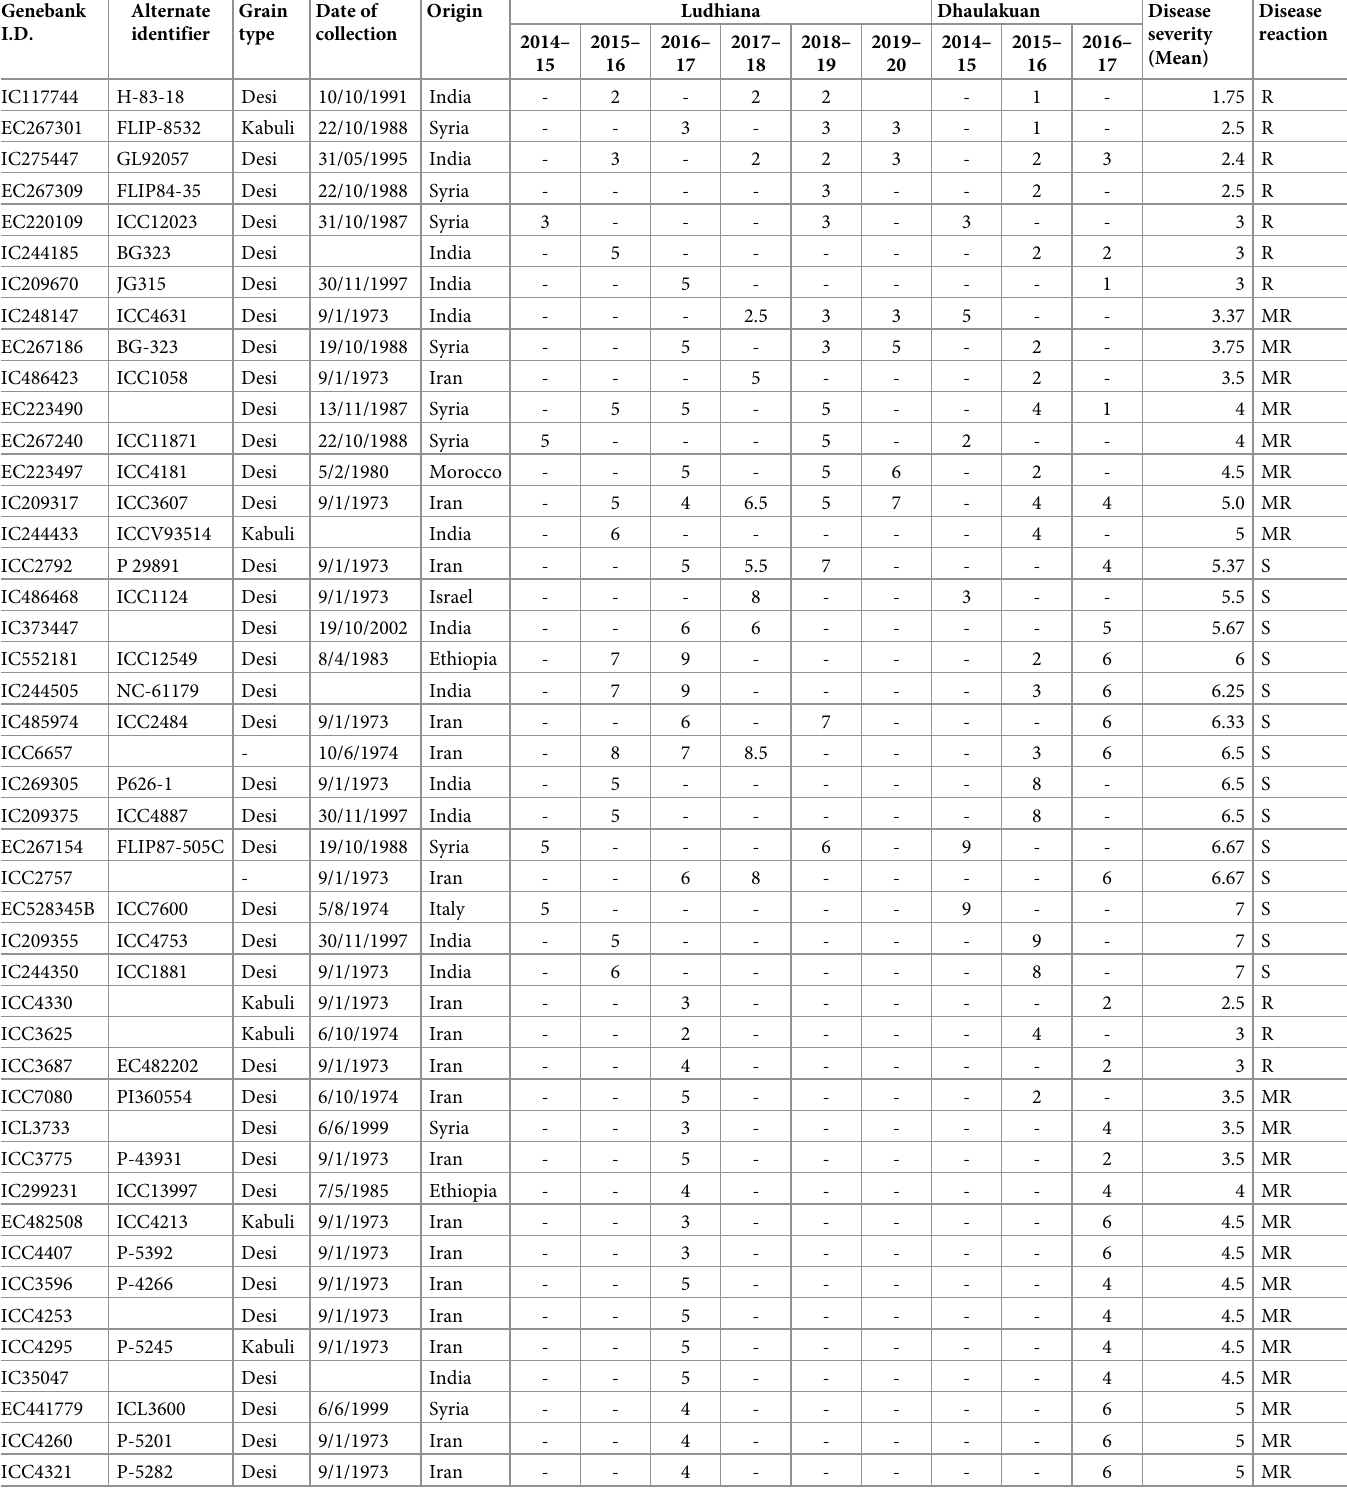
Table 2. Disease reaction (0–9 score) to Ascochyta rabiei pathogen and basic passport information of promising chickpea germplasm accessions identified from screening of 1,705 chickpea germplasm from 2014–15 to 2018–19. Genebank